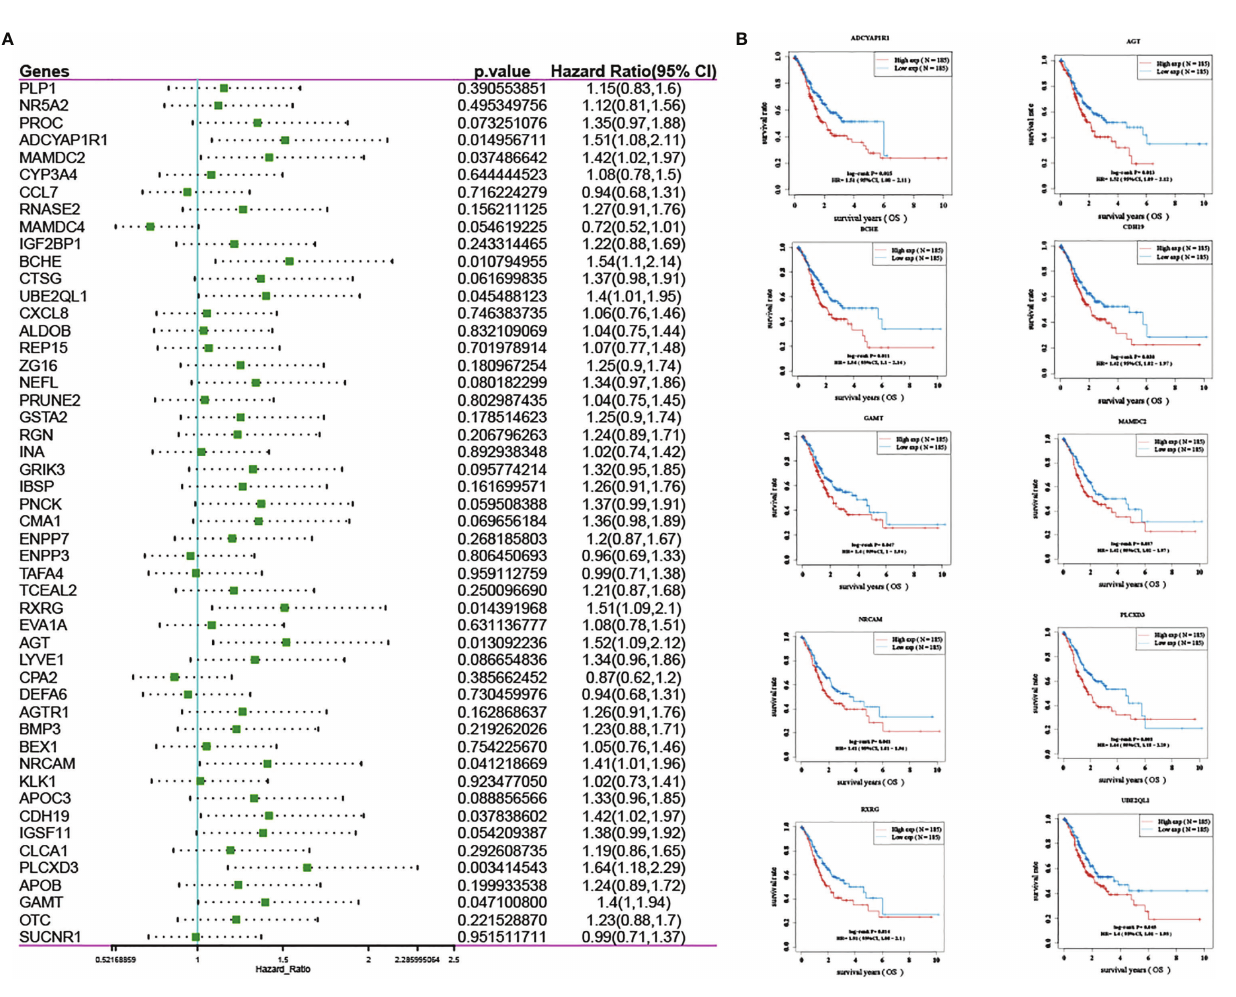
FIGURE 4 | Prognosis analysis: (A) forest map of screening prognostic genes; (B) KM curve of genes with prognostic signi fi